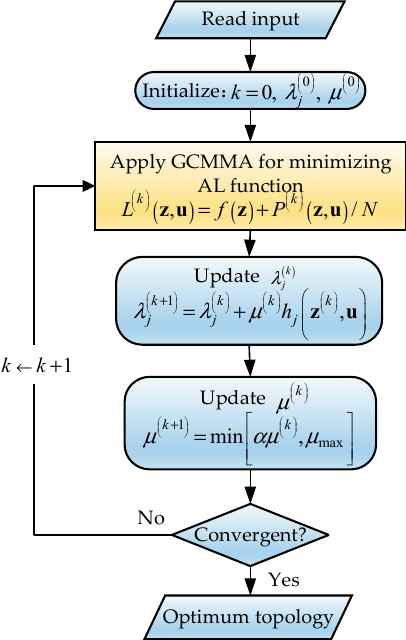
Figure 4. Schematic flowchart of the AL-based topology optimization framework.